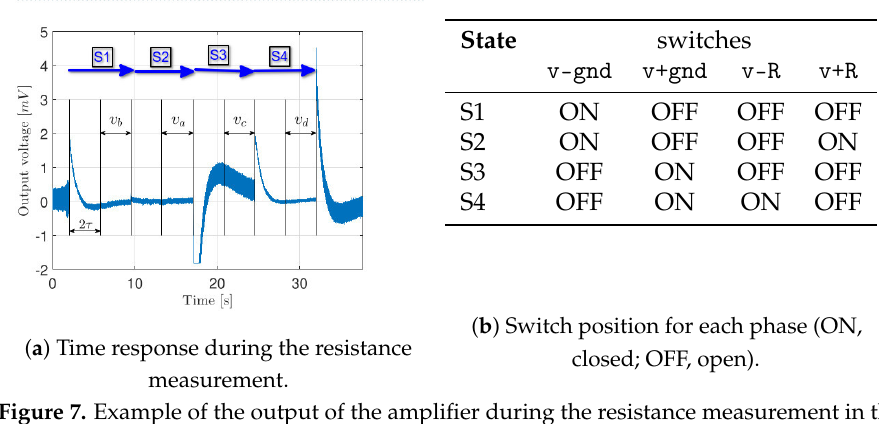
( b ) Switch position for each phase (ON, ( a ) Time response during the resistance closed; OFF, open). measurement. Figure 7. Example of the output of the amplifier during the resistance measurement in the system described in [22]. S1 to S4 are the four configurations of the input switches for each stage; normal operation is with all switches off. The table in ( b ) specifies the switch position for each stage.